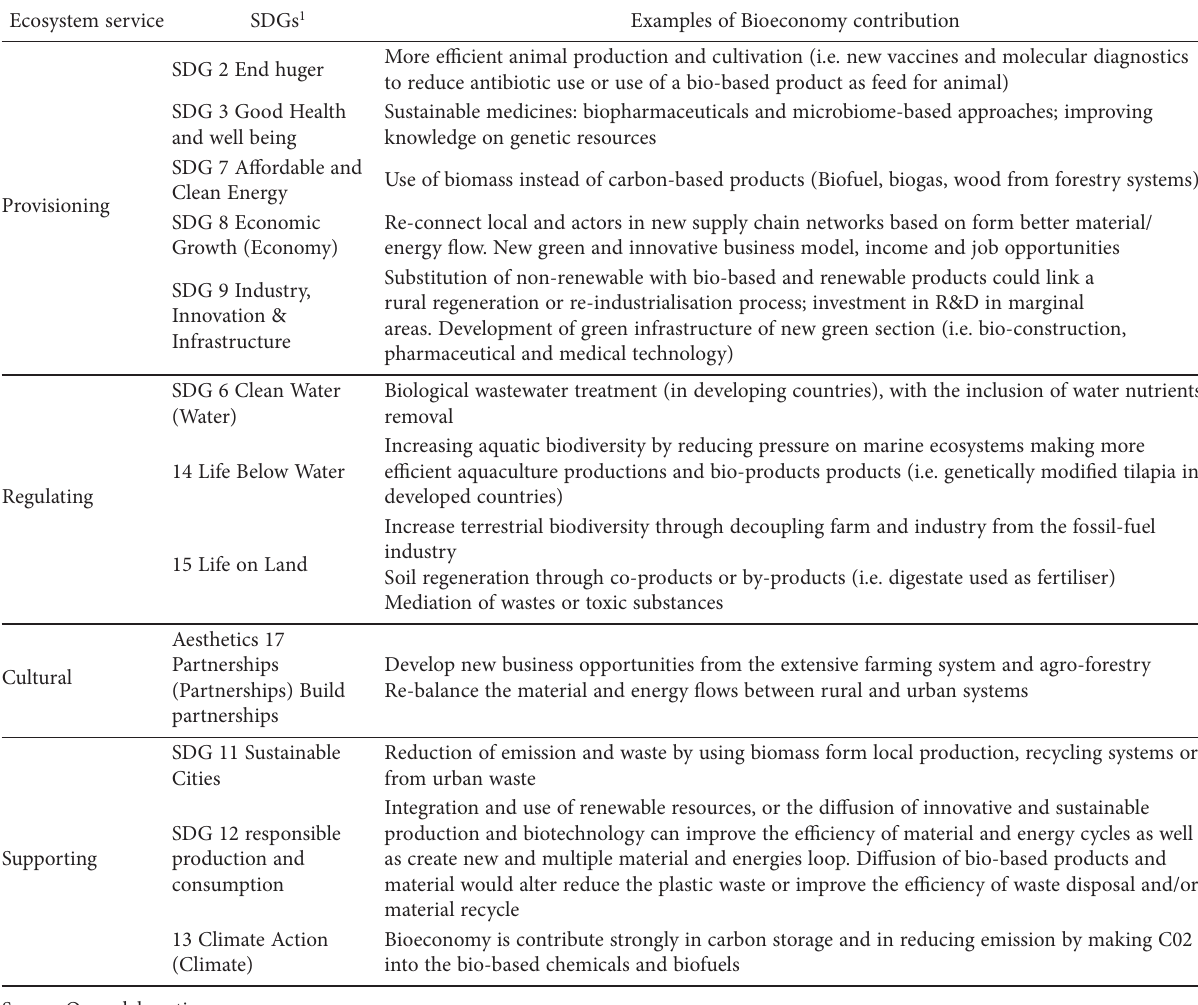
Table 2. summarises the linkages between ecosystem services, SDGs and Bioeconomy. Ecosystem service SDGs